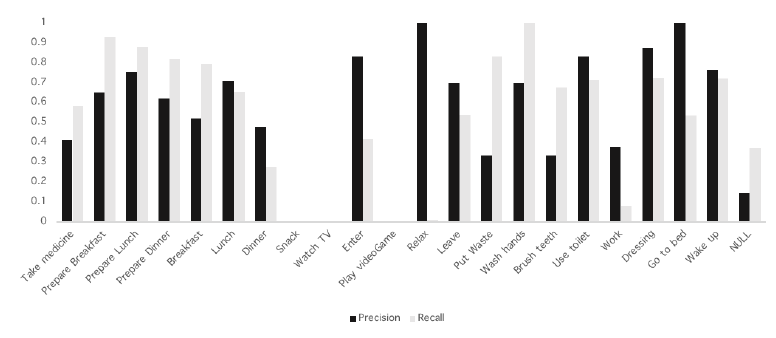
Figure 2. Precision and Recall for each activity on the UCAMI Cup test